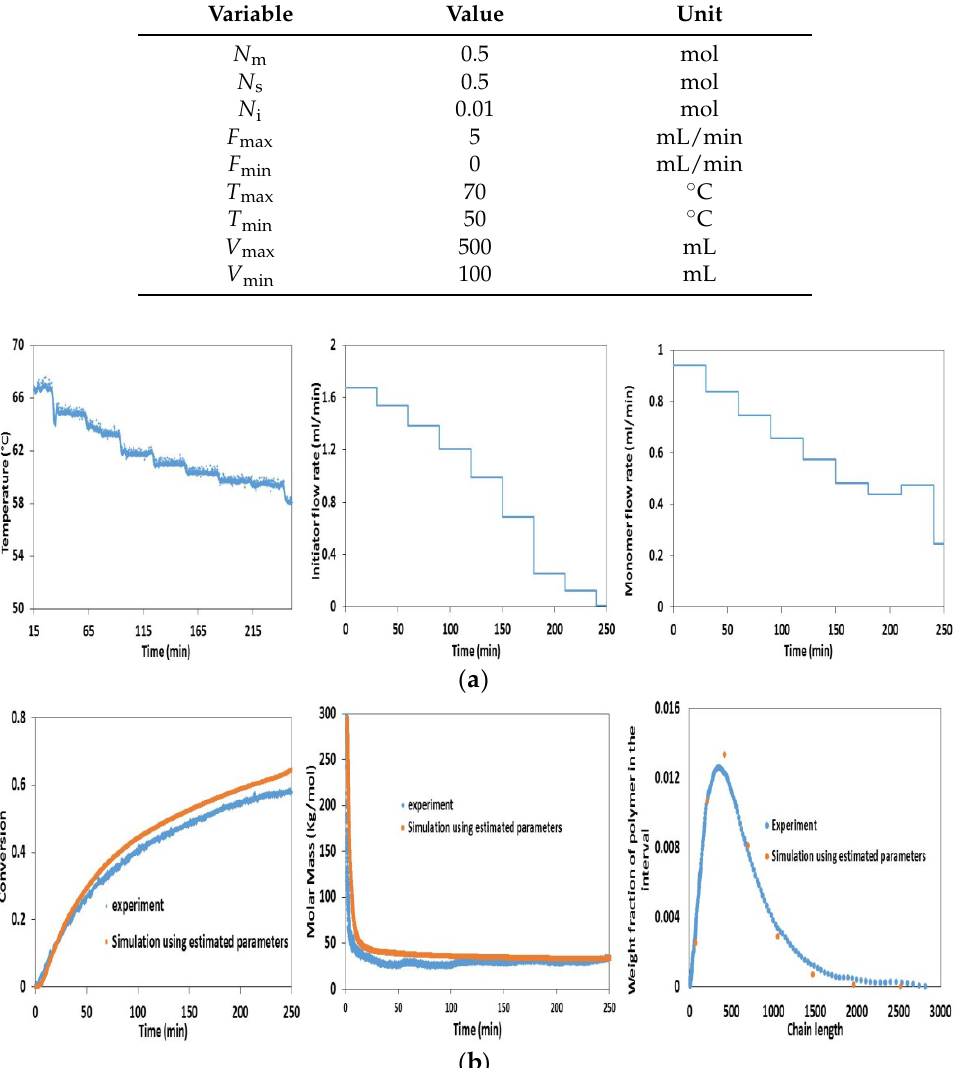
Figure 11. Validation of optimal runs: ( a ) Input (manipulated) variables; ( b ) Controlled variables (targets). To analyze the controllability of the system under feedback control and as a preliminary step towards the on-line feedback control implementation, a number of simulations combined with